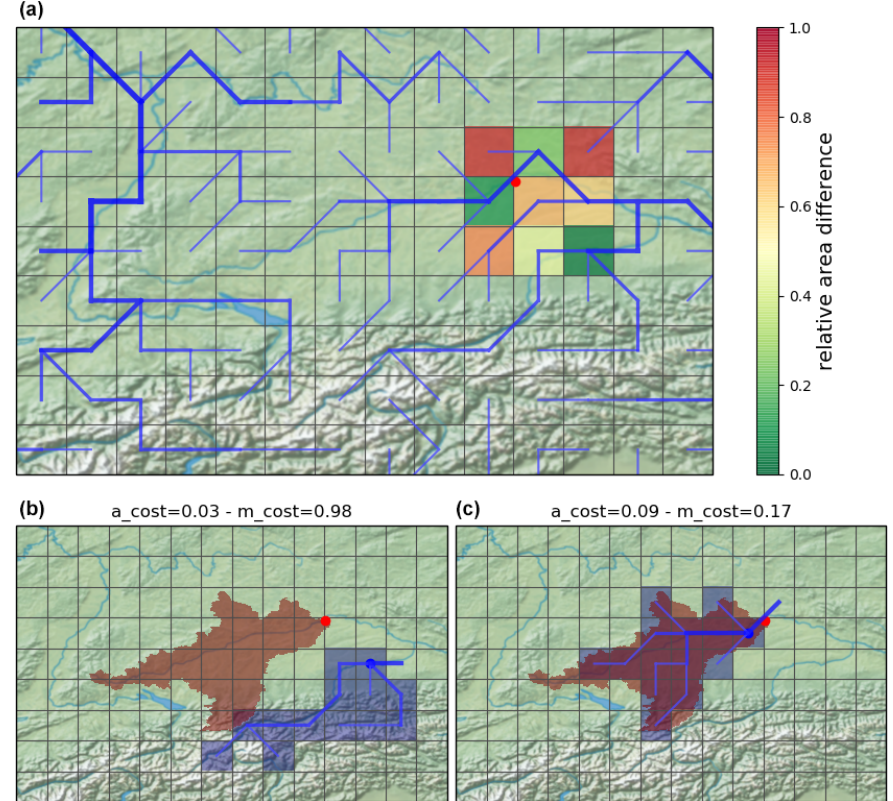
Figure 14. Example of necessary relocalization using the mask overlapping method. The station (red dot) is the Oberndorf station (GRDC id 6342910) on the Danube River (48.947 ◦ N, 12.0149 ◦ E). In the two lower panels, the real basin (from MERIT-Hydro) is shown in red. The lower left panel shows the CTRIP basin (in blue) for the cell with the drainage area closest to the drainage area reported at the station (i.e. the relative error in the area a cost is the lowest). The lower right panel shows the CTRIP basin for the cell with the lowest relative error in the mask overlap ( m cost